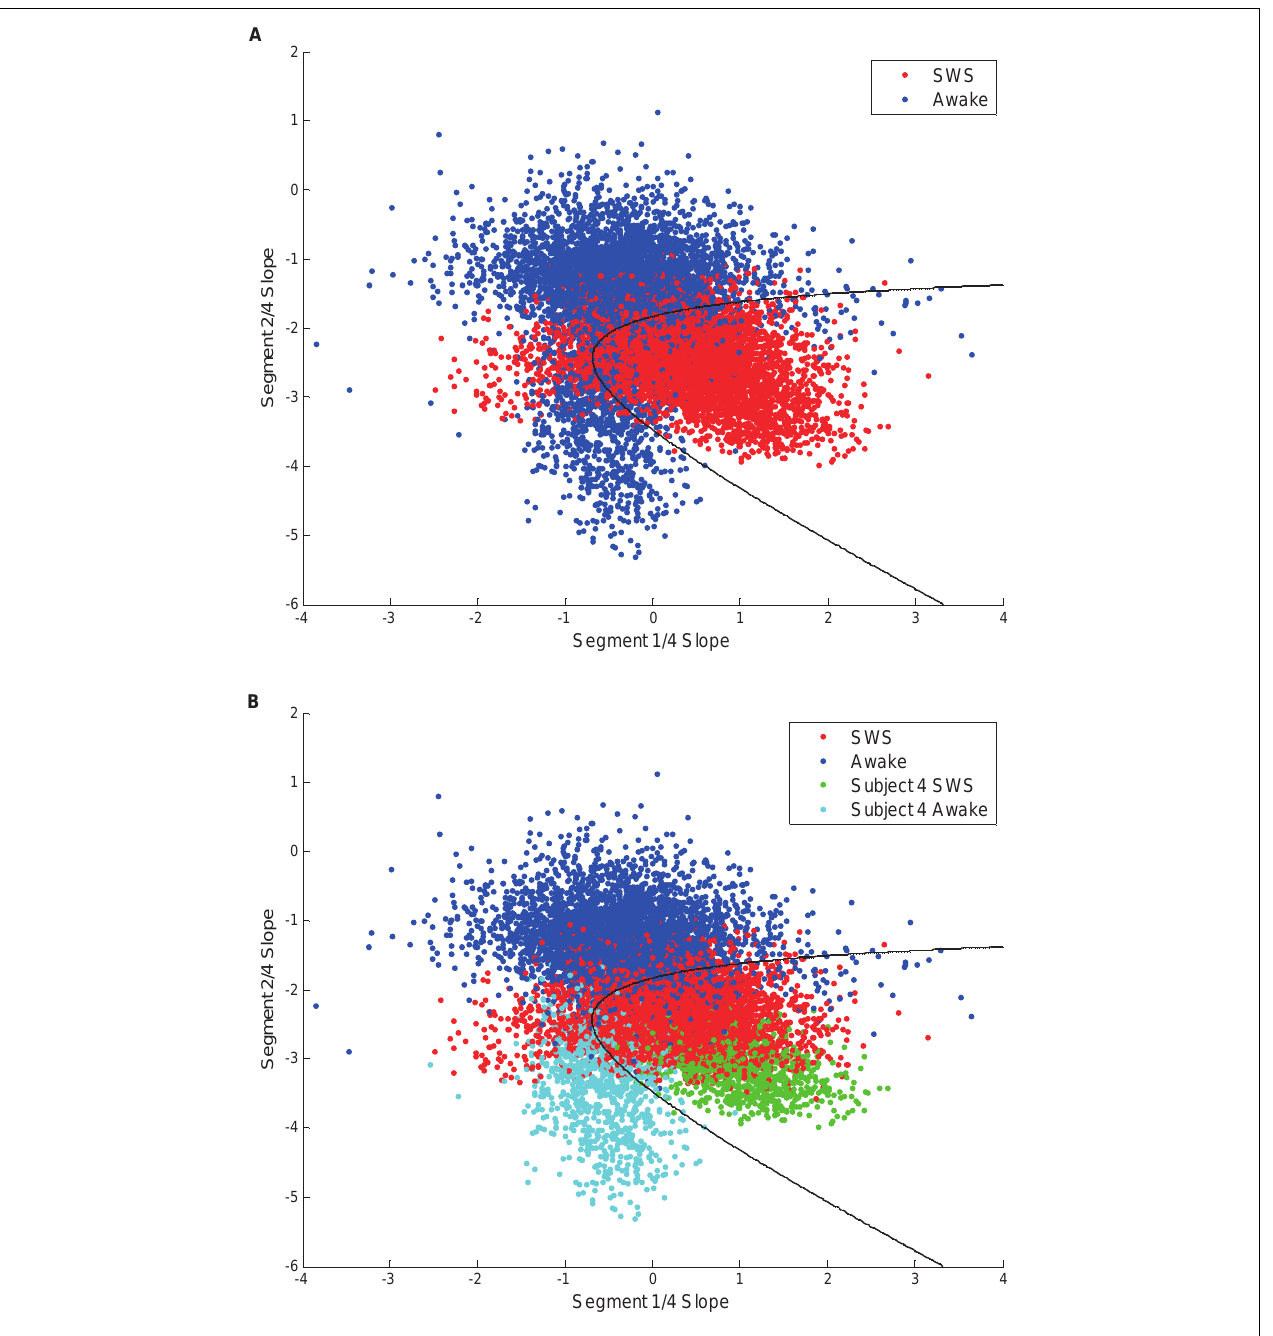
FIGURE 8 | (A) Scatter plot of segment one and segment two scale-free slope values in awake (blue) and SWS (red). Each point represents 30s data from one electrode.The black line represents a classifier decision boundary which best separates awake and SWS states in this feature space. MMLA